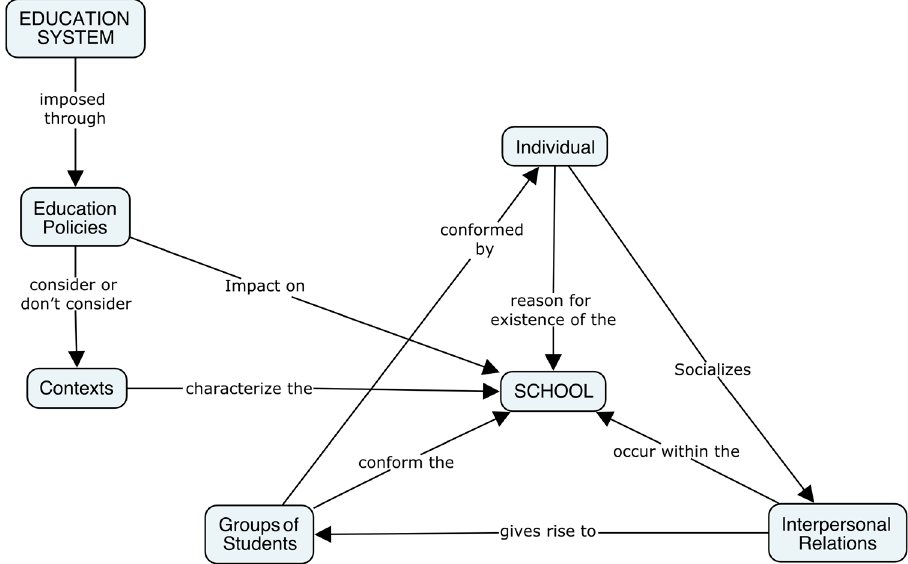
Figure 1. Levels of school violence. Source: prepared by the authors.